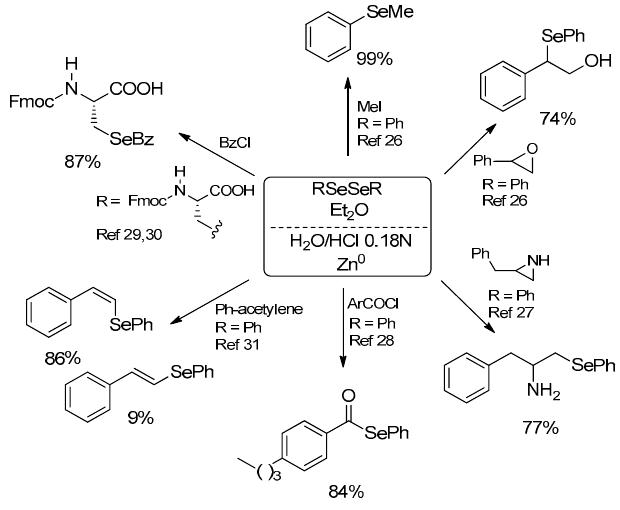
Figure 4. Synthetic applications of the zinc selenate prepared in the biphasic system.